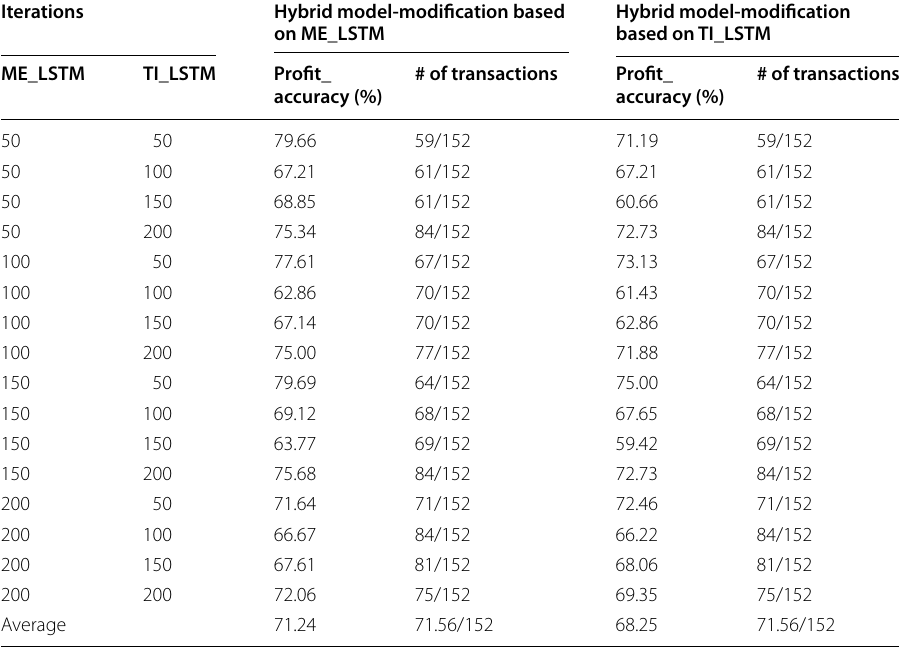
Table 19 Hybrid model (on extended dataset): five‑days‑ahead predictions